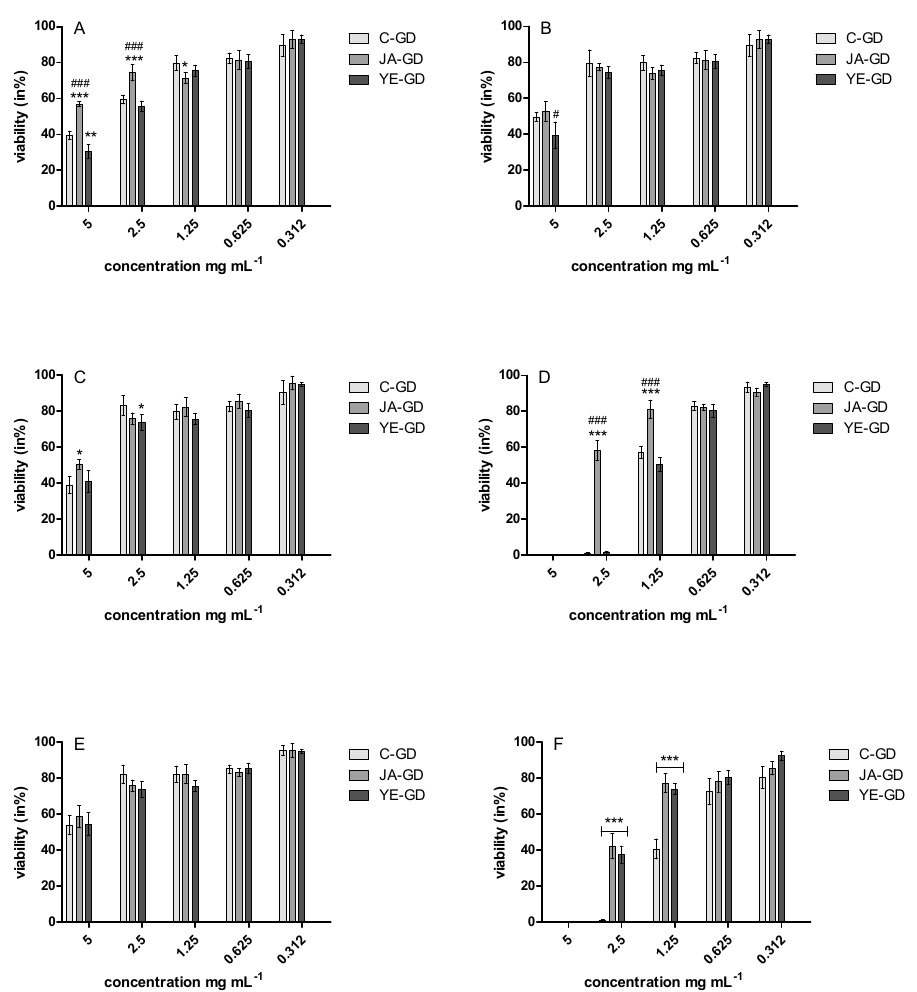
Figure 2. Viability (in %) of E. coli ATCC 25922 ( A ), S. aureus ATCC 29737 ( B ), S. enteritidis ATCC 4931 ( C ), B. cereus ATCC 14579 ( D ), L. monocytogenes ATCC BBA-2660 ( E ), and yeast C. albicans ATCC 90028 ( F ) against the gastrointestinally digested samples. C-GD—gastrointestinally digested extracts from the control plants; JA-GD—gastrointestinally digested extracts from the plants elicited with a solution of 10 µM jasmonic acid; YE-GD—gastrointestinally digested extracts from the plants elicited with 0.1% yeast extract .